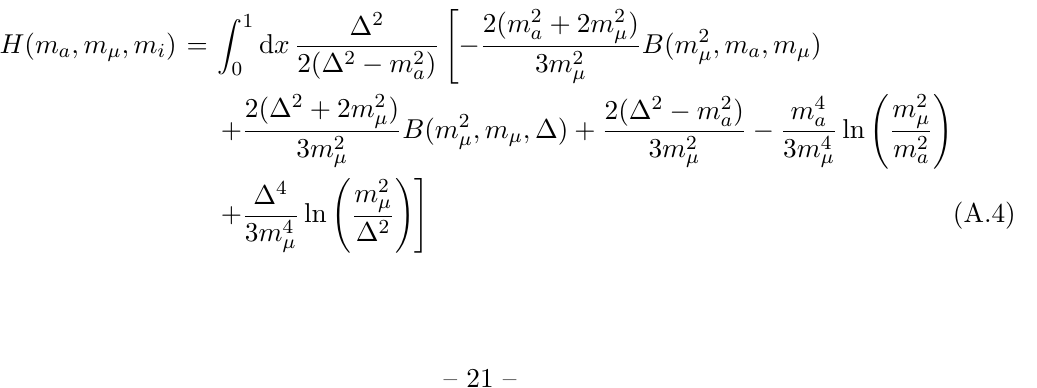
Figure 6 . Diagrams for muon g − 2 , inserting the vertex function i Γ µν ( k, q, m 2 correct physical answer, we must subtract equivalent diagrams with an insertion of i Γ µν ( k, q, Λ 2 ) in the large Λ limit. The internal loop momenta are taken independent of q because we work in the soft q limit, which is sufficient for extracting the magnetic dipole moment ambiguity in linearly divergent Feynman integrals is familiar from the calculation of the triangle anomaly (see, e.g., ref. [101]). The physically correct answer arises from